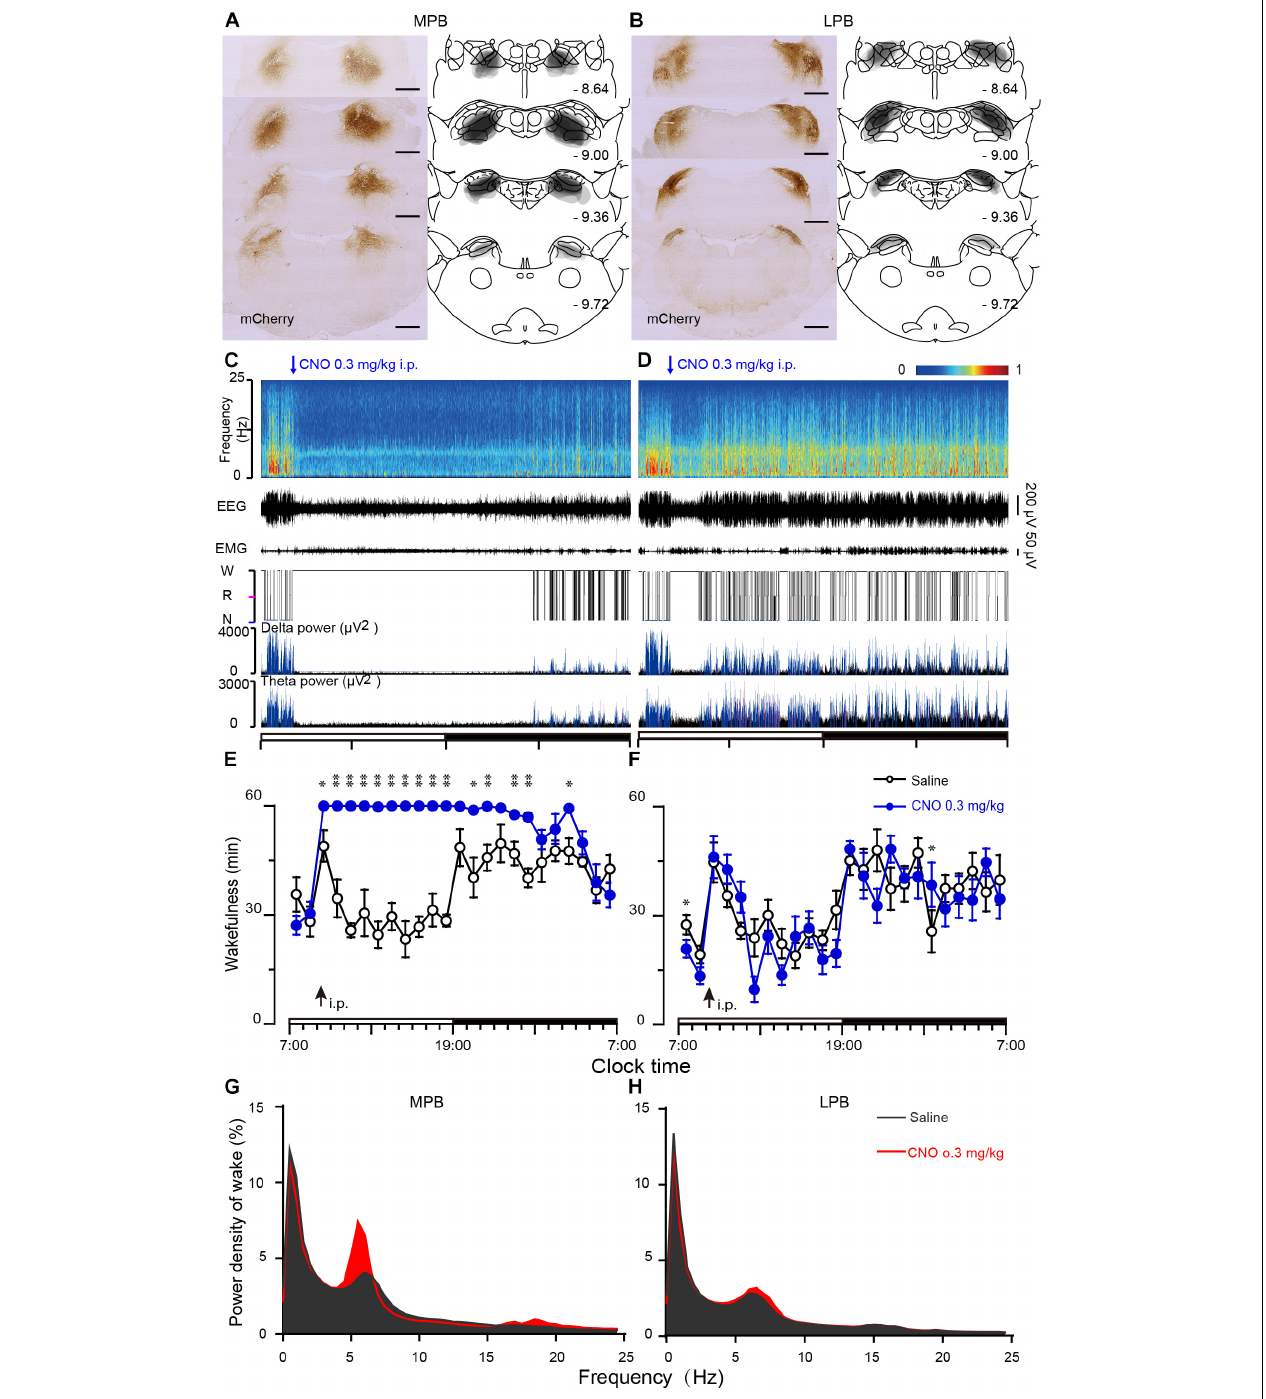
FIGURE 1 | Chemogenetic activation of MPB (but not LPB) neurons induces wakefulness. (A,B) Schematic diagram indicating the position of hM3Dq-mCherry protein was confined to the MPB (A) or LPB (B) . Superimposed mCherry expression areas in the MPB (A) and LPB (B) of 8 AAV-injected rats in each group, are shown in the right panels (Paxinos and Watson, 2007). Scale bars: 1 mm. (C,D) Typical examples of EEG power spectra, EEG, EMG, hypnogram, and relative magnitude changes in delta and theta power over 24 h for a rat expressing hM3Dq at MPB (C) or LPB neurons (D) when given CNO (0.3 mg/kg). (E,F) Time courses of wakefulness after administration of CNO (0.3 mg/kg) or saline in rats expressing hM3Dq in MPB (E) or LPB neurons (F) . The arrow indicates the time point of CNO or saline administration, and open and closed bars above the x -axis indicate light and dark periods, respectively. (G,H) EEG Power spectrum of wakefulness during 10 h (9:00–19:00) after the CNO injection in MPB-hM3Dq (G) and LPB-hM3Dq rats (H) . * P < 0.05, ** P < 0.01, compared with saline ( n = 8).